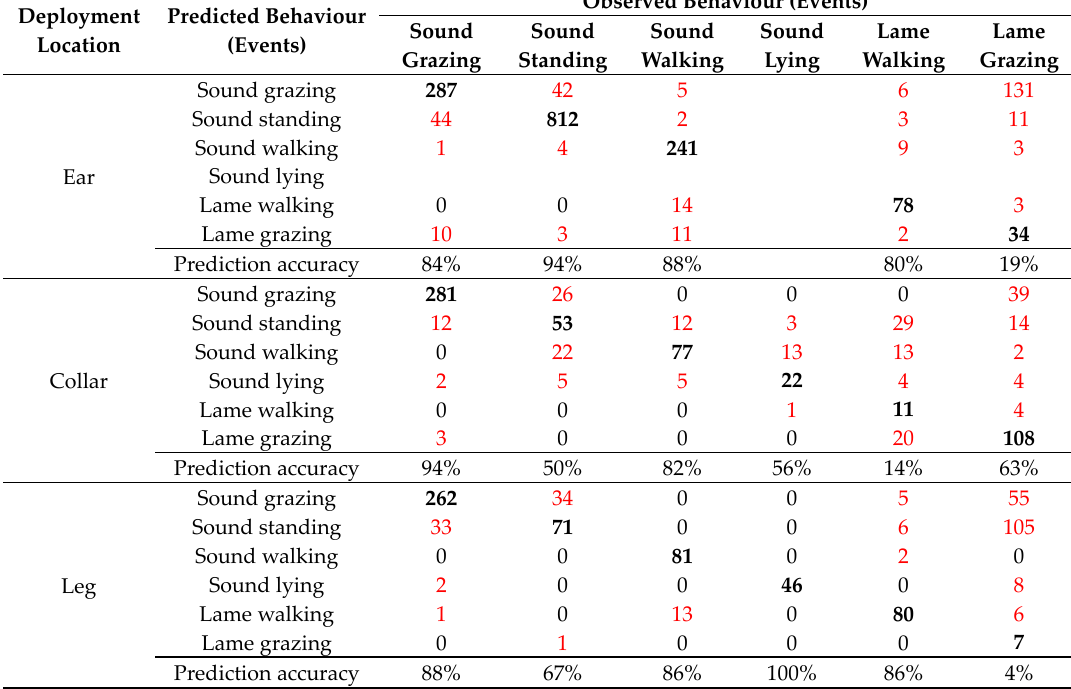
Table 5. QDA confusion matrices of the leave-one-out cross validation analysis for the classification of six mutually exclusive behaviours (Analysis I) using accelerometers deployed in three locations (collar, leg, and ear). The QDA algorithm used the top three ranked metrics from the respective data sets for the discrimination of behavior. Correctly predicted events are shown in bold and misclassifications in red.